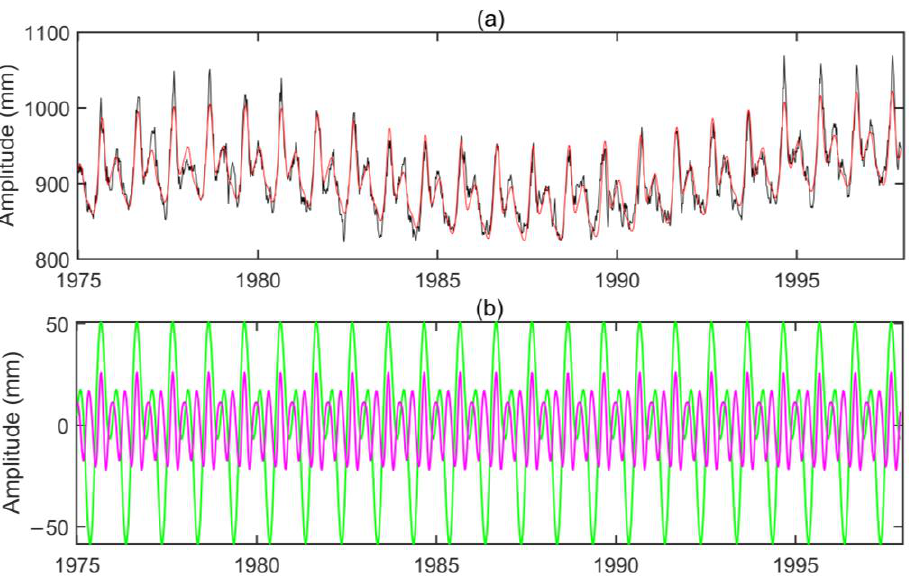
Figure 4. ( a ) The observed (black line) and fitted (red line) weekly K 1 amplitudes at Beihai. ( b ) Seasonal (green line) and subseasonal (pink line) variations in K 1 amplitudes at Beihai.